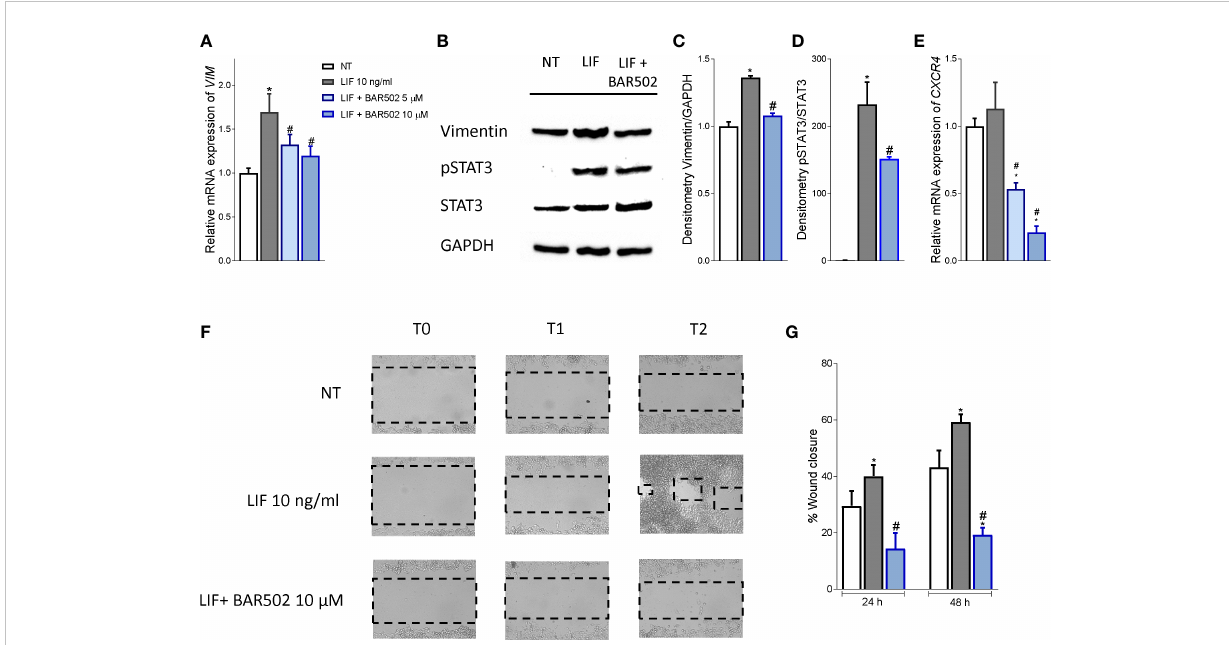
FIGURE 6 BAR502 inhibits in vitro migration in STAT3-dependent signalling. MIA PaCa-2 cells were serum-starved for 24 hours and exposed to LIF (10 ng/mL) alone or in combination with increasing concentrations of BAR502 (5, 10 m M) for 24 hours. Data displayed are: (A) Relative mRNA expression of the EMT markers, VIM. Each value is normalized to GAPDH and is expressed relative to those of positive controls, which are arbitrarily set to 1. (B) Representative Western blot analysis of Vimentin, phospho-STAT3 and STAT3 proteins in MIA-PaCa-2 cells exposed to LIF (10 ng/ml) alone or plus BAR502 (10 m M) for 20 minutes. (C) Densitometric analysis demonstrating Vimentin/GAPDH and (D) phospho-STAT3/STAT3 ratio. (E) Relative mRNA expression of the prognostic marker, CXCR4. Each value is normalized to GAPDH and is expressed relative to those of positive controls, which are arbitrarily set to 1. (F, G) Scratch wound healing assay. MIA PaCa-2 cell monolayers were scraped in a straight line using a p200 pipette tip; then, they were left untreated or primed with LIF 10 ng/mL alone or in combination with BAR502 10 µM. The wound generated was captured at 0, 24 and 48 h of incubation with the compounds above described. The images show cell migration at the three times point indicated. (G) Images of obtained points were analysed, measuring scraped area and its closure vs the fi rst time point at 0 (h) Results are the mean ± SEM of fi ve samples per group (* represents statistical signi fi cance versus NT, and # versus LIF, p <